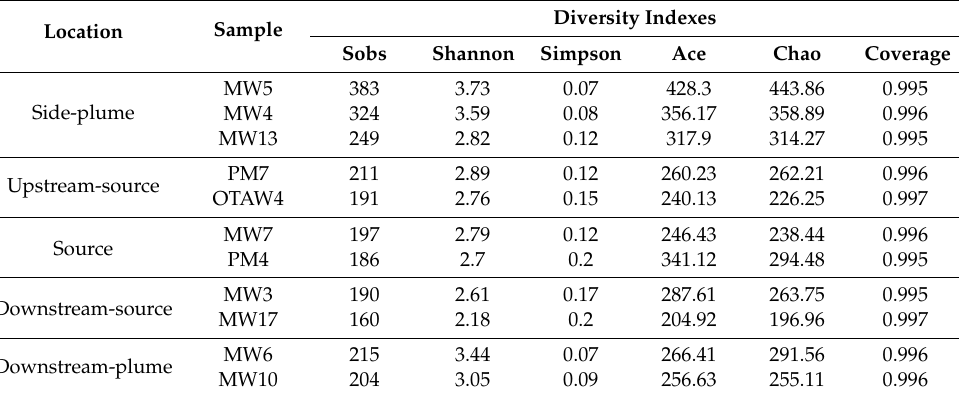
Table 2. Alpha-diversity